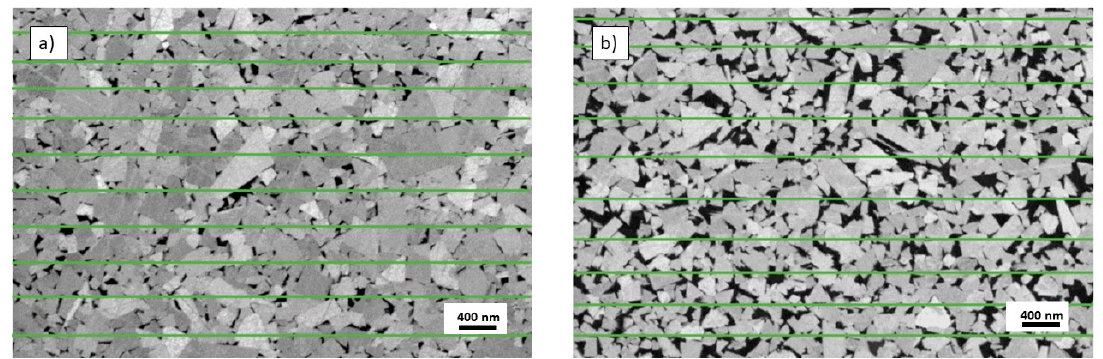
Figure 16. Line intercept method grain size determination of the substrate at 20,000 × magnification: ( a ) SH-5; ( b ) SH-15.